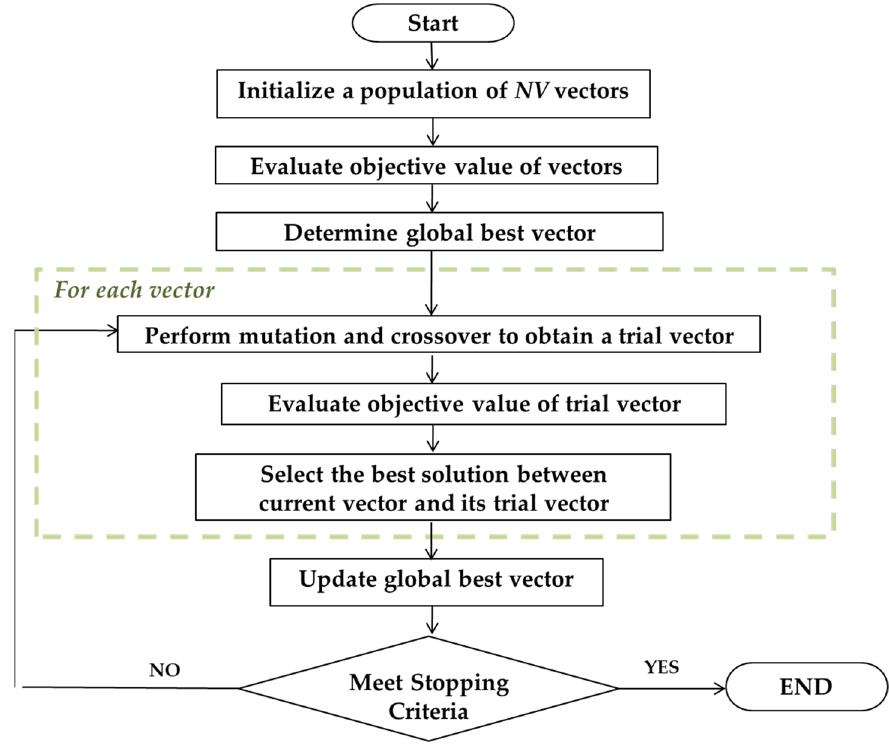
Figure 2. Evolutionary procedure of the differential evolution (DE) algorithm.